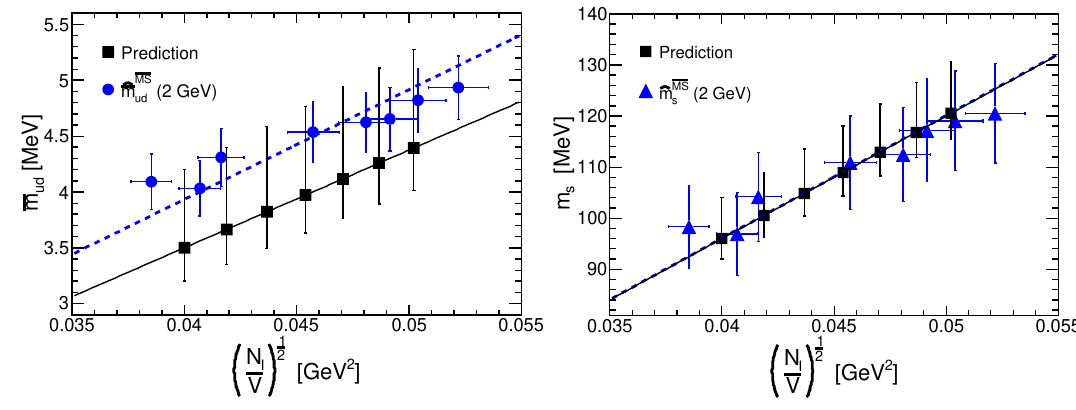
Figure 23 . Comparisons of the light quark masses (cid:22) m MS scheme at 2 [GeV] with the predictions. The black and blue lines indicate the (cid:12)tting results of the predictions and numerical results,